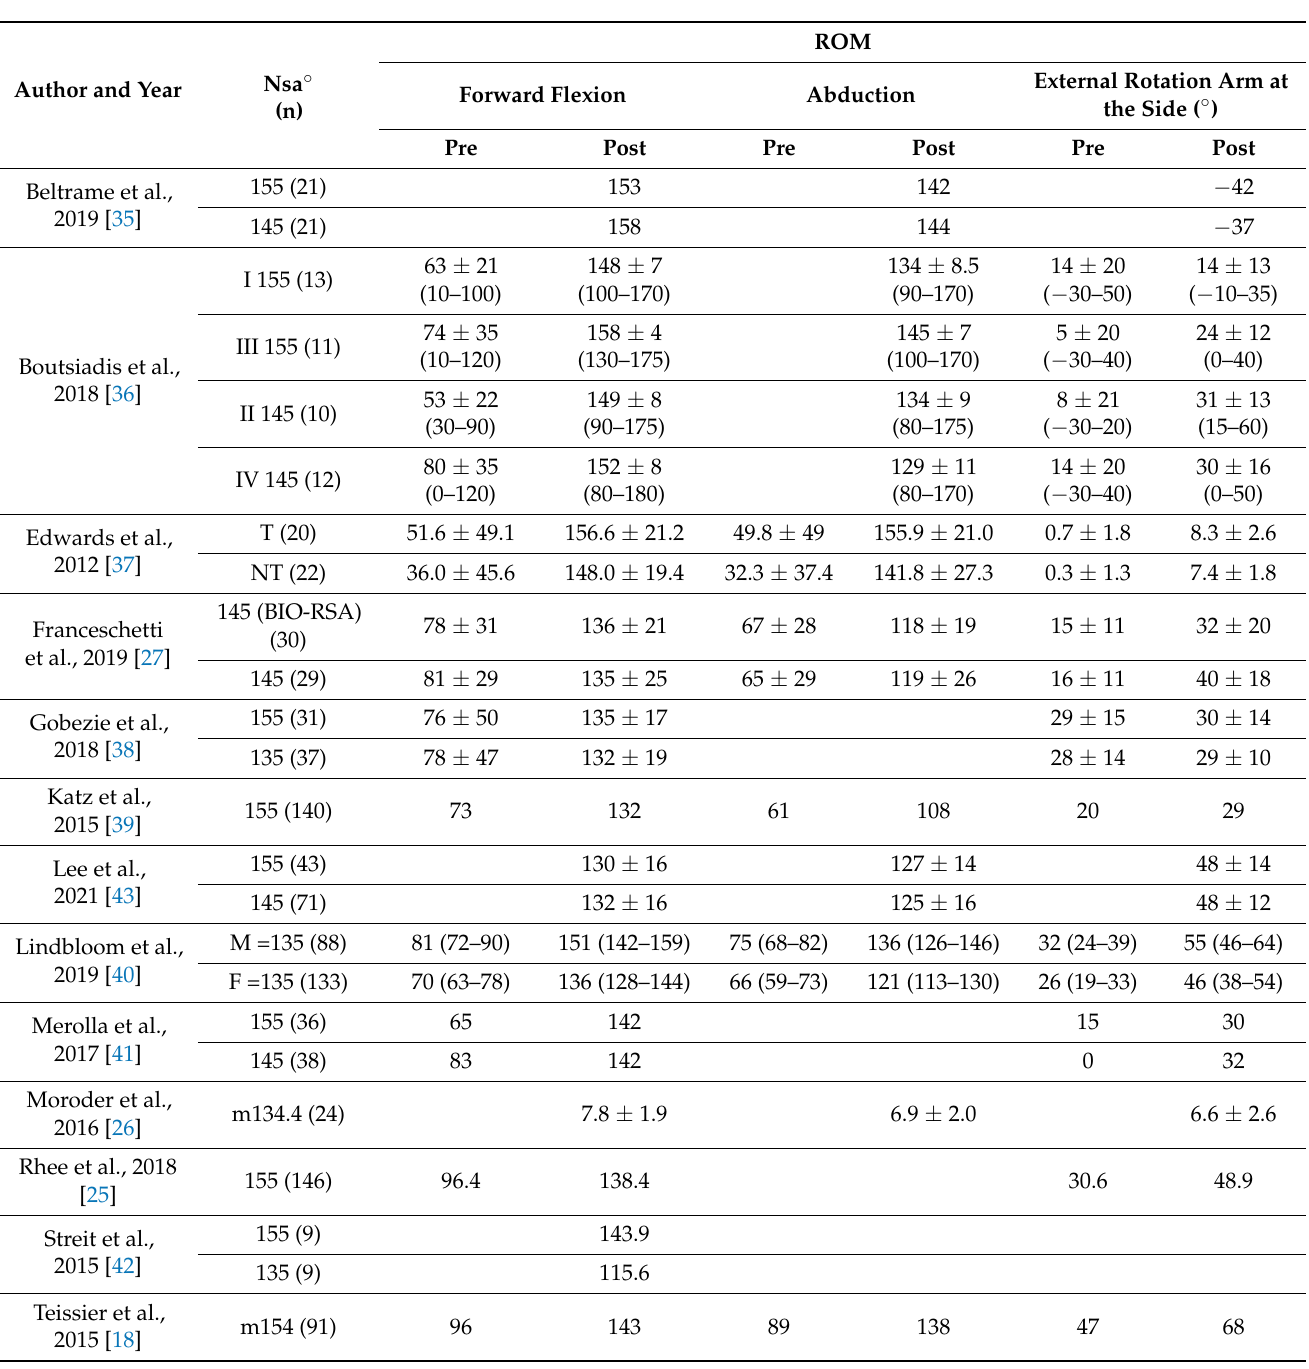
Table 6. Active ROMs (forward flexion, abduction, and external rotation with the arm at side) of the studies